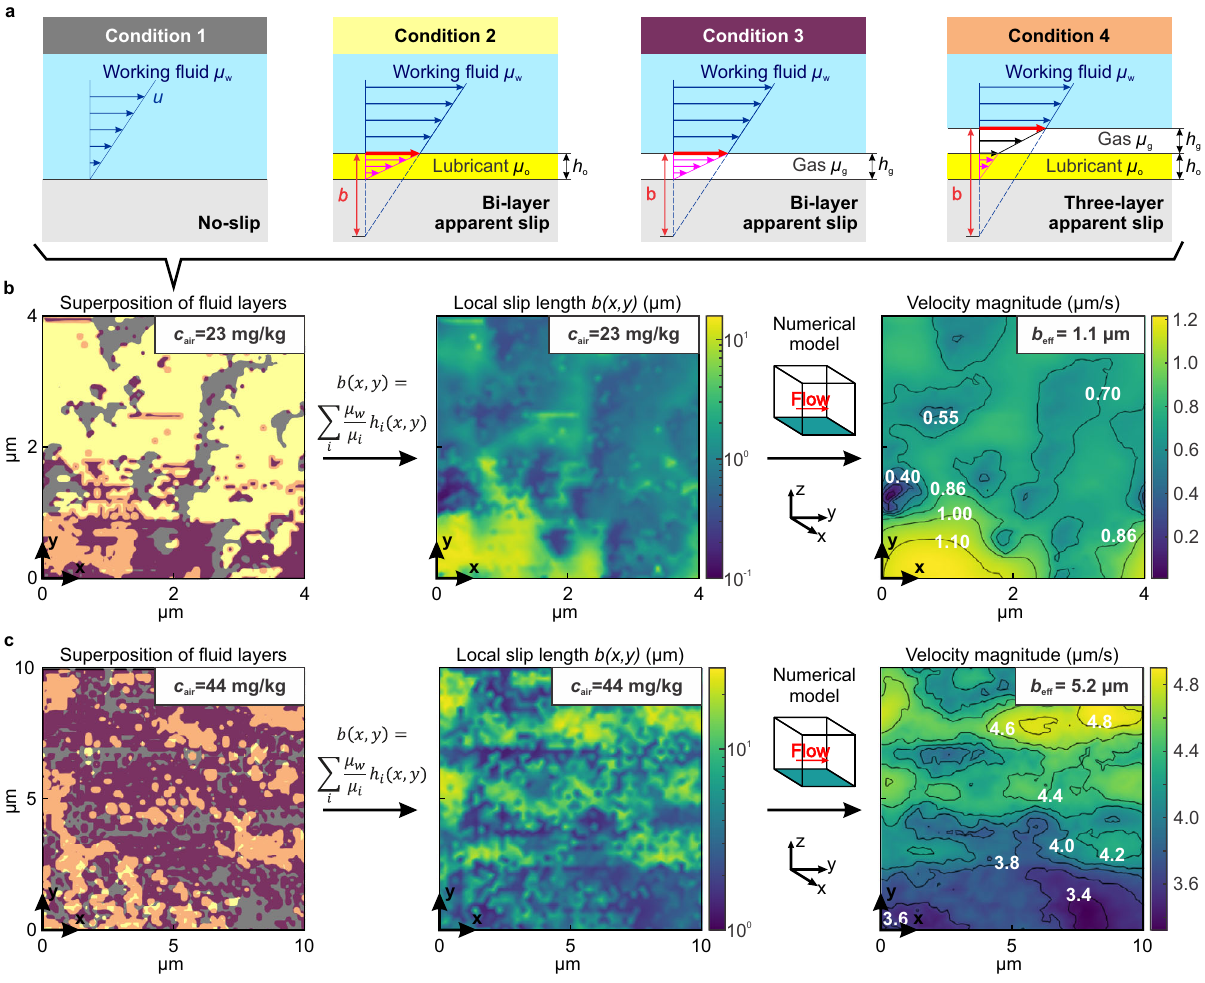
Fig. 5 Fluid fl ow boundary condition and local slip on lubricant-infused surfaces. a Schematic of the boundary conditions experienced by the working fl uid on the solid surface on different lubricating fl uid layers. b Left panel: spatial distribution of the lubricating fl uid layers for a surface immersed in Milli-Q water with air content c air ~ 23.0 ± 0.3 mg kg − 1 (derived from atomic force microscopy map in Fig. 4b). The colors represent the fl ow conditions shown in ( a ). Central panel: map of the local slip length b ( x , y ) estimated at a horizontal plane located at the highest peak of the wrinkled Te fl on. b ( x , y ) is computed as the sum of the apparent slip length given by each fl uid layer according to Eq. (1), based on the lubricant layer thickness h o and h g measured by atomic force microscopy. Right panel: magnitude of fl uid velocity immediately above the Te fl on wrinkles, computed from a three-dimensional numerical model, for a tangential shear rate _ γ ¼ 1 s − 1 in the y − direction . Black lines are contour lines for the velocity. b eff = 1.1 μ m is the theoretical effective slip computed from the model. c Same panels as in ( b ), calculated for a surface immersed in gassed water in which c air ~ 44 ± 4 mg kg − 1 (atomic force microscopy map shown in Supplementary Fig. S13). Source data are provided as a Source Data fi